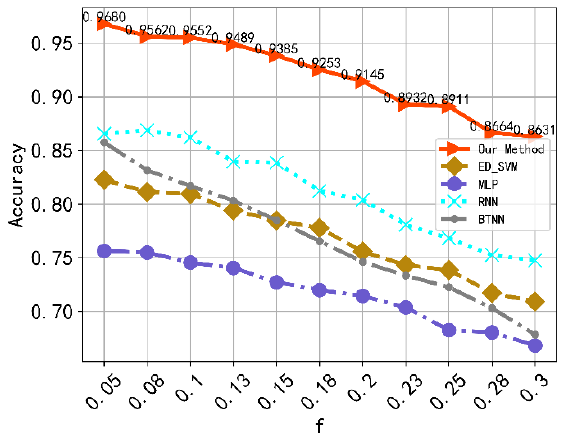
Figure 9. Curves of the accuracy of the four methods changing with f .